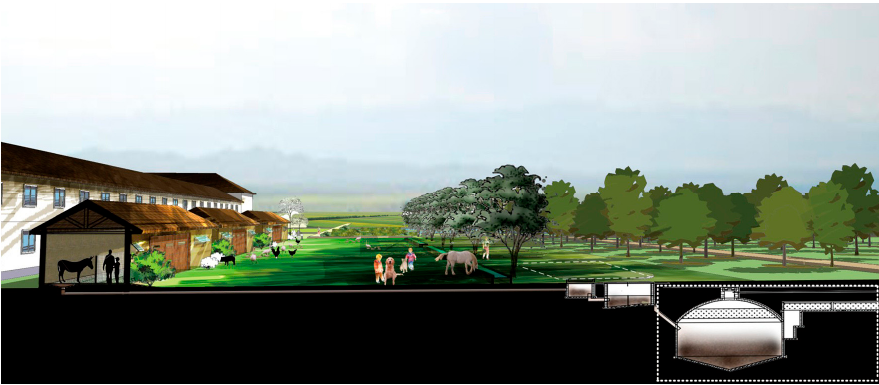
Figure 10. Prospective section of the existing farmhouse (cascina) regenerated and the new landscape designed as public space and energy production through biomass.